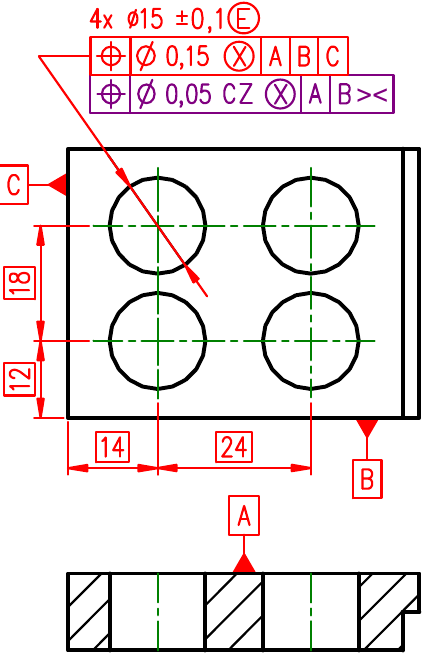
Figure 16. The ISO GPS system specification equivalent to the requirement given in Figure 15a. The position tolerances in Figures 13a and 15a are locating axes of the holes. According to ASME Y14.5, the axis of the hole is derived by using the actual mating envelope, which contacts the highest points of the hole surface (axis of the maximum inscribed